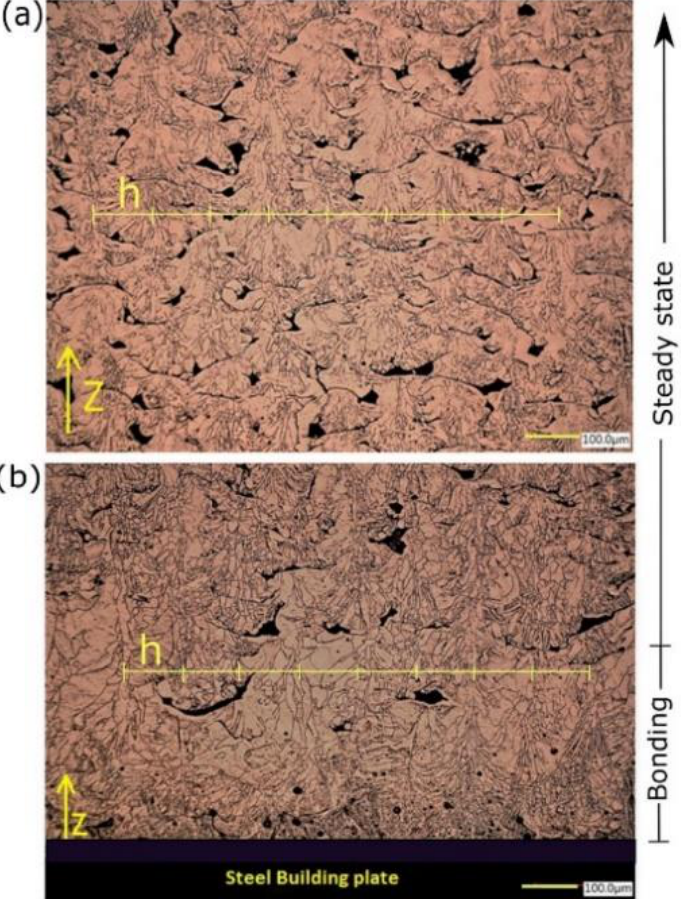
Figure 11. Grain morphology of the L-PBF Cu sample at two locations: ( a ) midpoint and ( b ) close to the steel building plate.